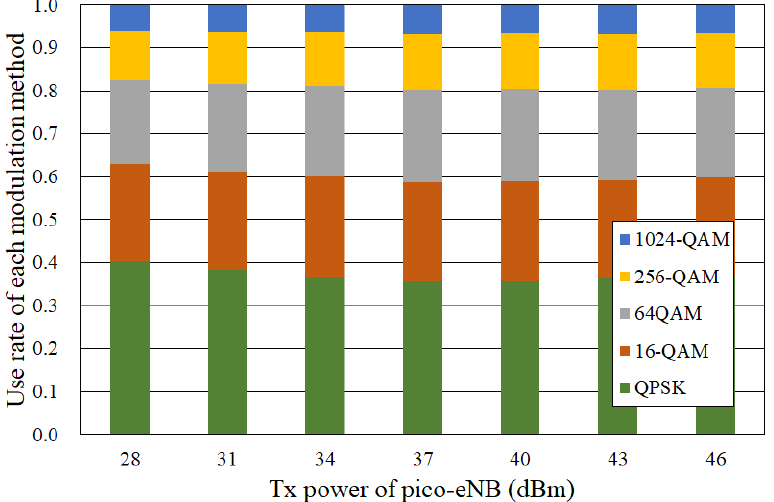
Figure 10. Analysis of use rate of modulation method used in downlink MCS as a function of pico-eNB Tx power.